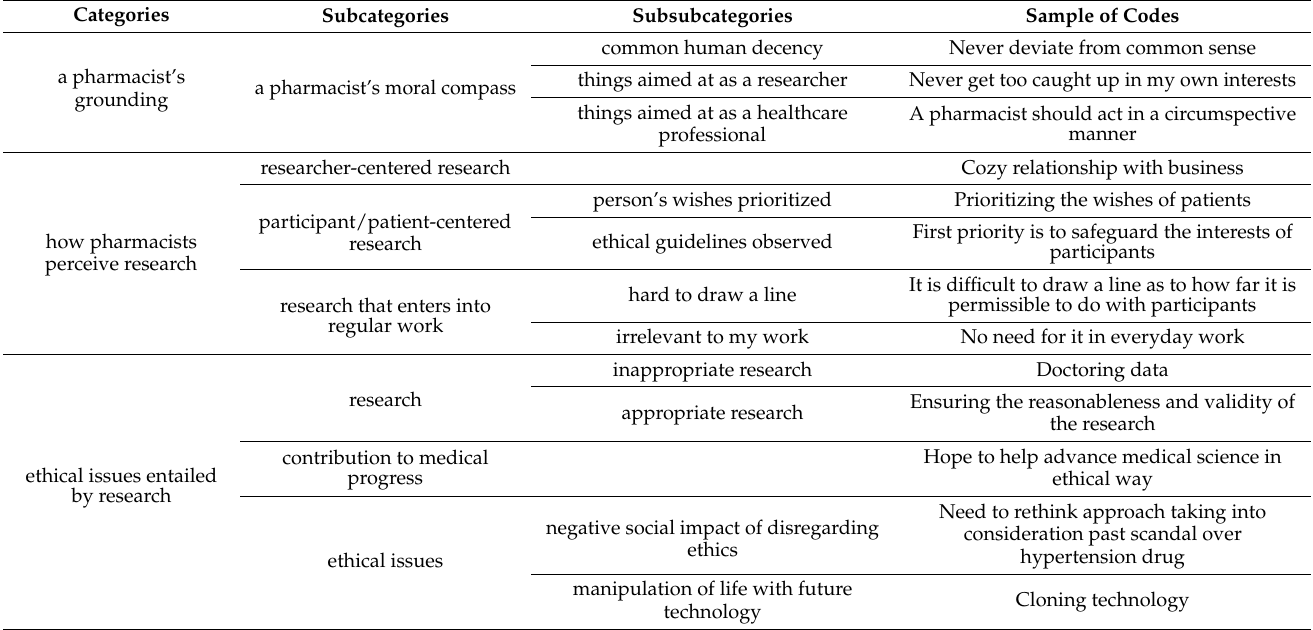
Table 1. Category, Subcategories, Subsubcategories, and Sample of